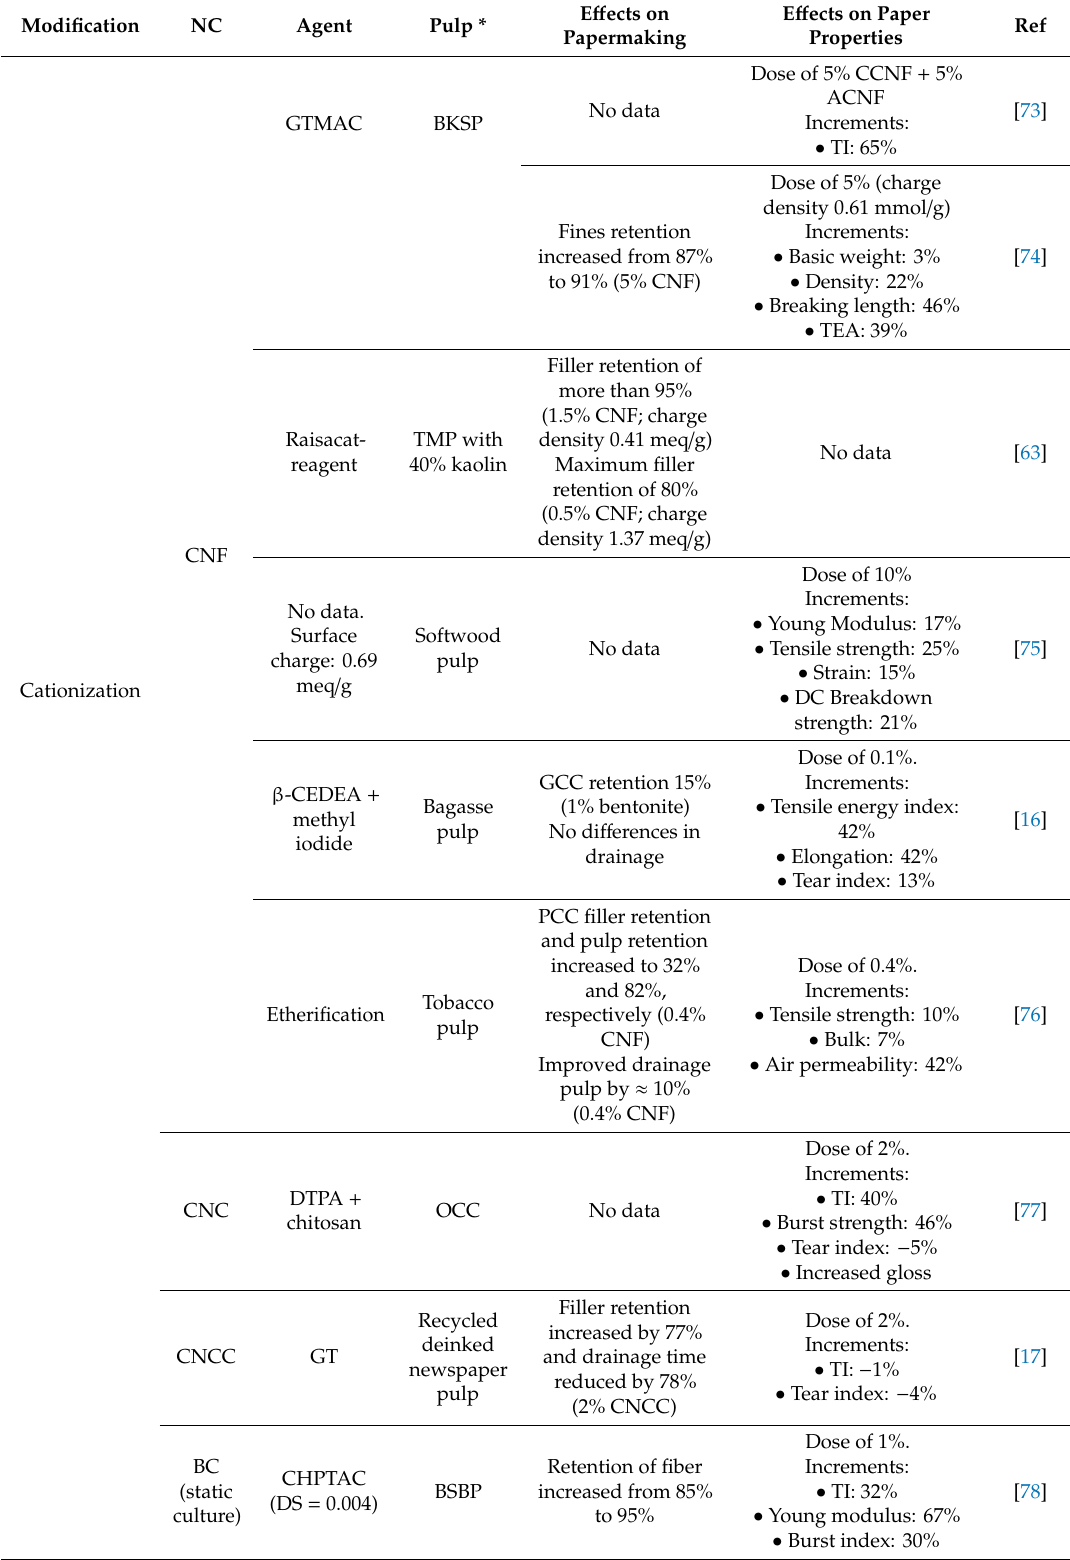
Table 2. E ff ects of modified NC on papermaking (e ff ects with respect to the situation without NC).